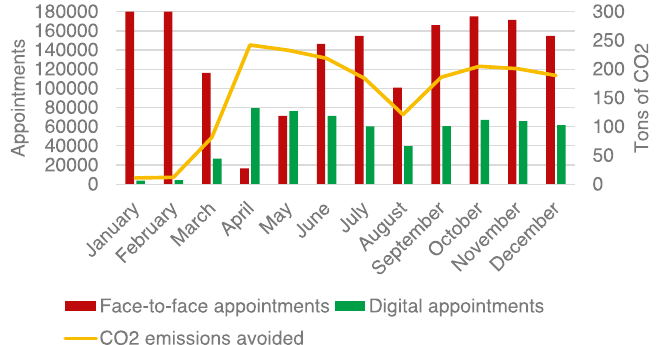
Figure 1. Number of appointments and CO 2 emissions avoided. Evolution of the number of face-to-face and digital appointments made monthly during 2020. The yellow line shows the monthly CO 2 emissions avoided, resulting from multiplying the number of digital appointments by the average savings of 3.057 kg of CO 2 for every digital